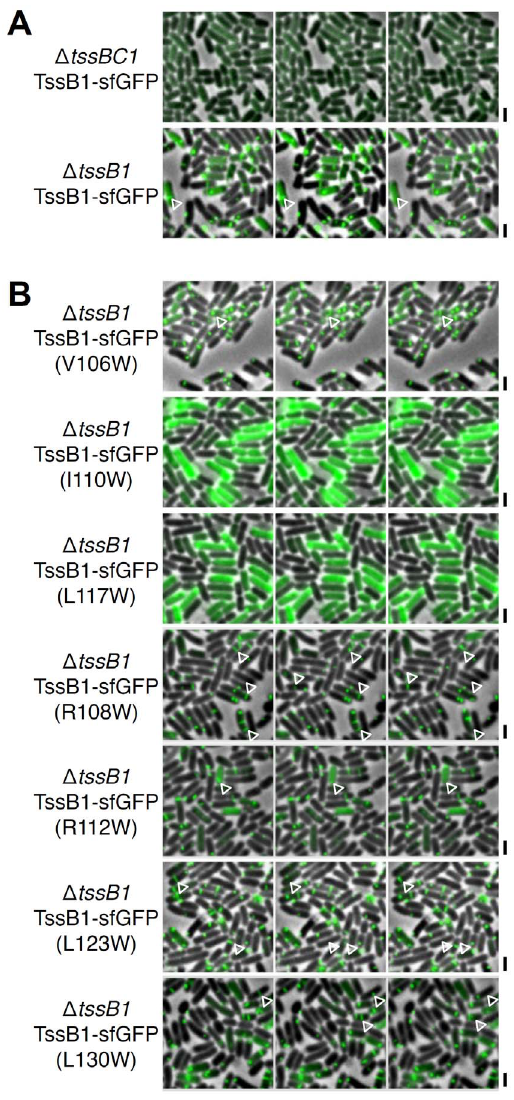
Figure 5. The hydrophobic motif of the TssB1 a -helix is required for T6SS sheath assembly. Time-lapse fluorescence microscopy recordings showing sheath dynamics in D tssBC1 ( D tssB1 - D tssC1 ) or D tssB1 cells producing TssB1-sfGFP (TssB1) (A) or TssB1-sfGFP bearing the indicated substitutions (B). Individual images were taken every 30 sec. Assembly and contraction events are indicated by the white open triangles. Scale bars are 2 m m.